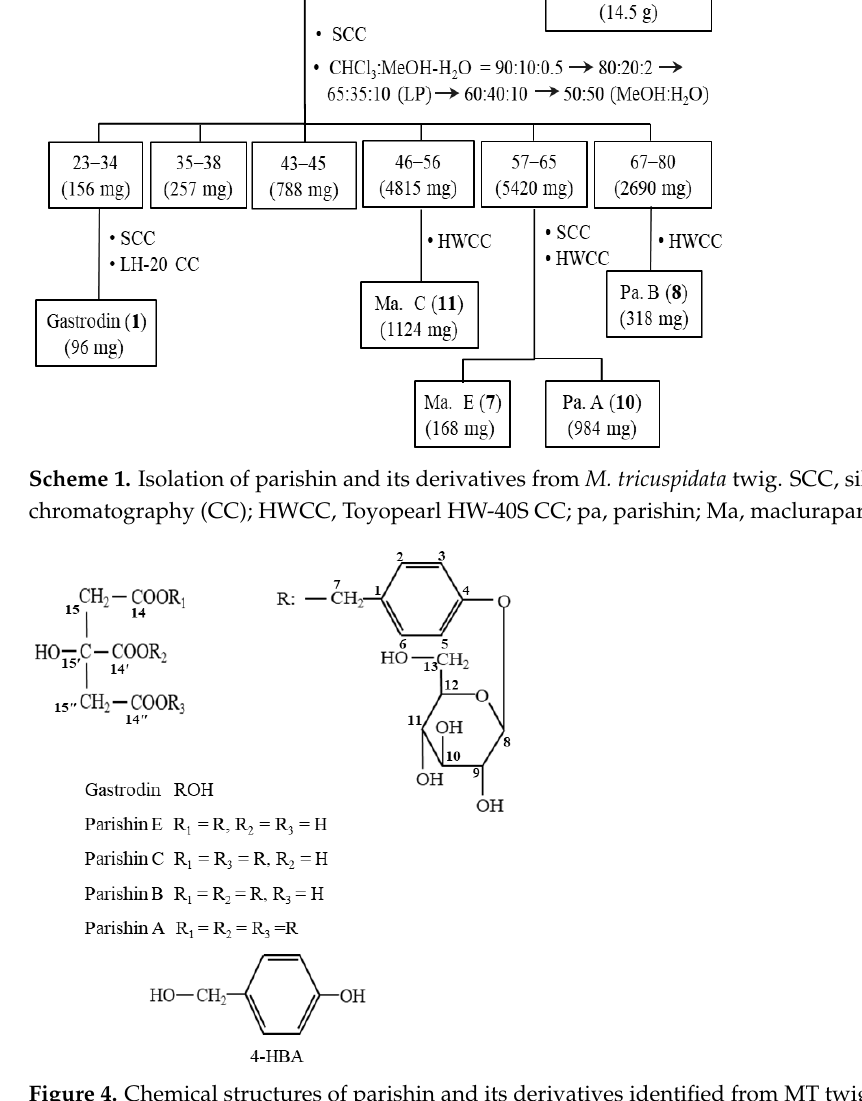
Figure 4. Chemical structures of parishin and its derivatives identified from MT twig.